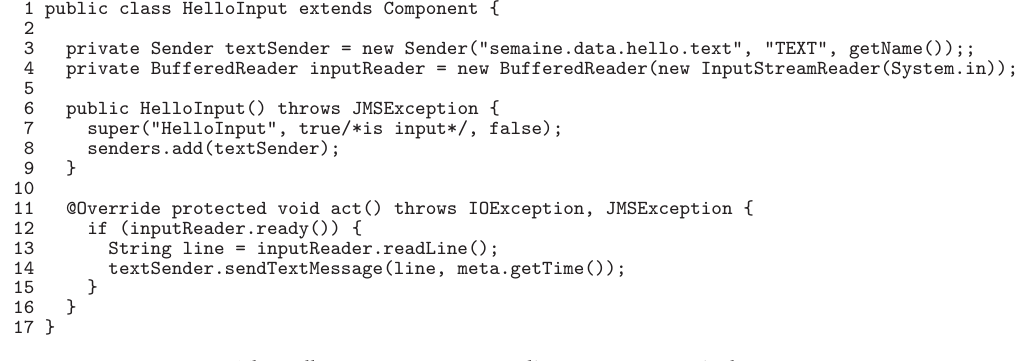
Figure 12: The HelloInput component sending text messages via the SEMAINE